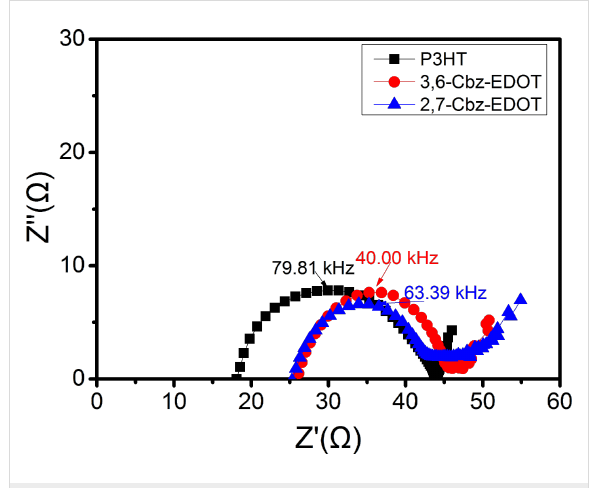
Figure 4: Impedance spectroscopy characterization of the PSCs with different HTMs over the frequency range from 1 Hz to 1 MHz at 0 V bias voltage under simulated AM1.5G illumination (100 mW cm − 2